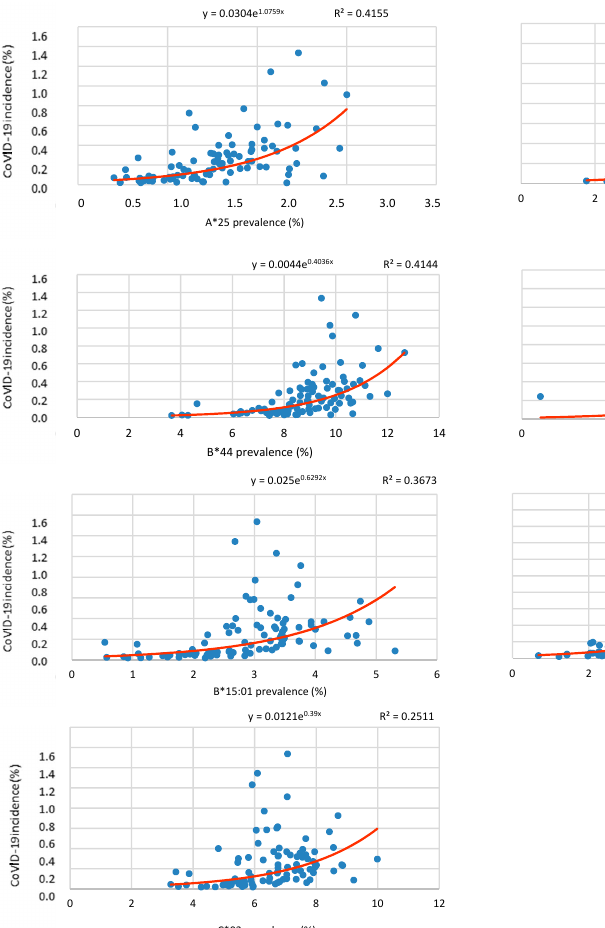
Figure 2. Correlation between COVID-19 incidence rate and HLA prevalence. The graphs show the correlation between COVID-19 incidence and the prevalence of HLA-A*25, B*08, B*44, B*15:01, B*51, B*14, B*18, B*49, C*01, and C*03, expressed as percentages, for all the available Italian provinces. For each